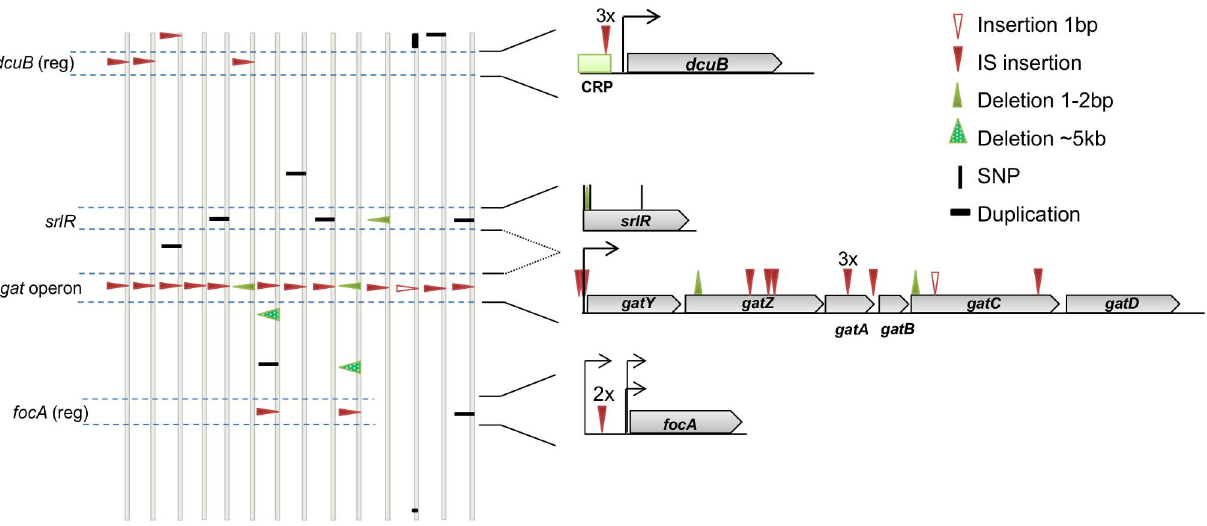
Figure 3. The genetic basis of adaptive mutations and the level of parallelism between populations. Identified mutations in clones isolated from populations 1.1 to 1.14 (evolved in vivo for 24 days), represented along the E. coli chromosome. For simplicity, the genomes are represented linearly and vertically drawn. The type and position of mutations are shown by triangles for insertions and deletions, small vertical bars denote single nucleotide polymorphisms (SNPs), and one duplication in clone number 1.12 is depicted as a horizontal bar. See the symbol legend for other events. The genes dcuB , srlR and focA and one operon ( gat ) are highlighted. These represent regions of parallel mutation in at least two genomes. The genomic context of these mutations is represented on the right. (reg) after the gene name, means that the regulatory region, rather than the coding region, was affected. Numbers above marked mutations represent the number of times a particular mutation was detected at the same position.